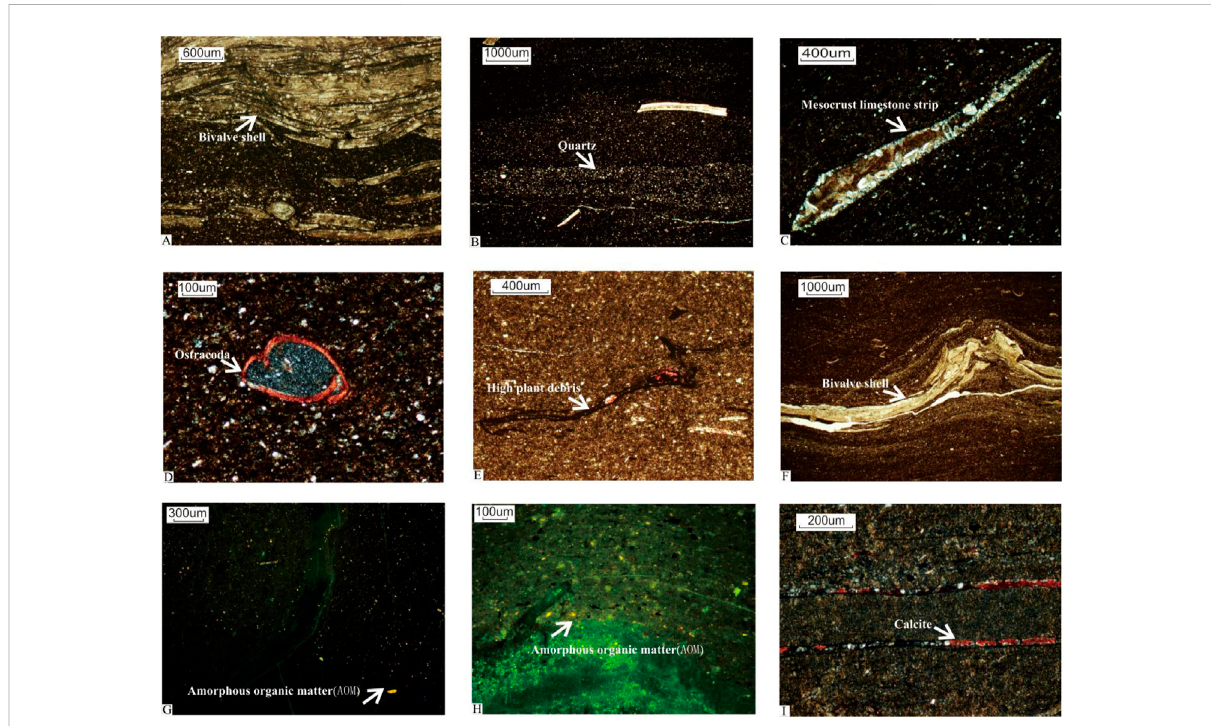
FIGURE 2 Micrographs ofthe Da ’ anzhai member (A) interbedded shale and limestone, bivalve shell,3675.34 m, well A; (B) silt-bearing shale, 3672 m,well A; (C) pure black mud shale clip shell limestone belts, 3637.55 m; (D) silt-bearing calcareous mudstone, shale, ostracod, 3639.18 m, well A; (E) grapholith,higherplants,3667.97 m,wellA; (F) shale,bivalveshell,1745.9 m,wellB; (G) shale,amorphousorganicmatter(algae),2432 m,wellD; (H) shale, amorphous organic matter (algae), 2466 m, well D; (I) interbedded shale and limestone, 1720.99 m, well